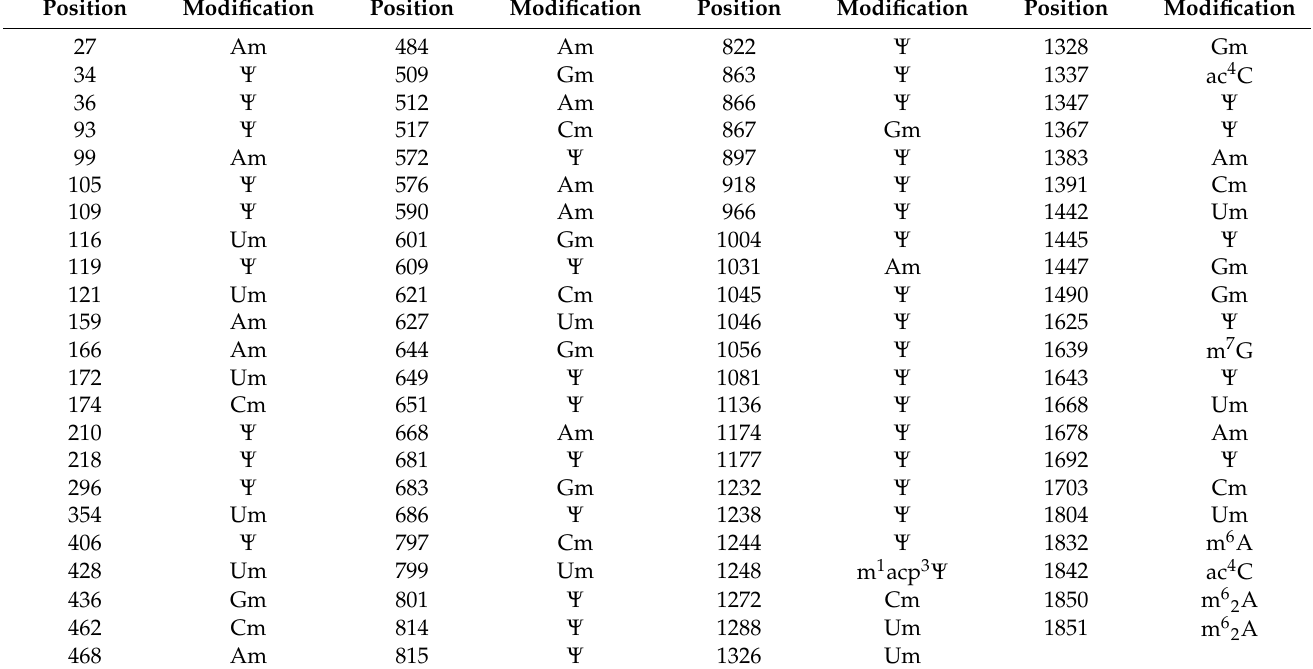
Table 2. Position and type of RNA modifications that have been detected in human 18S